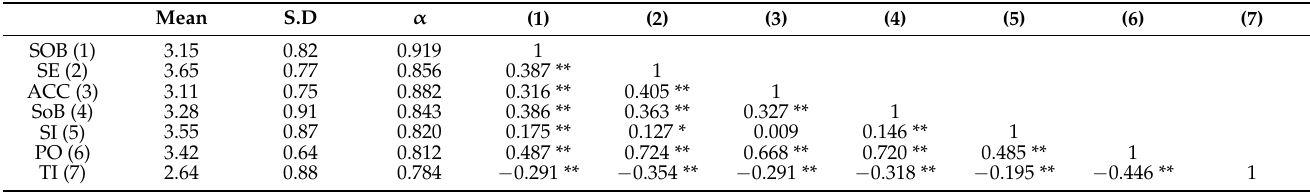
Table 3. Descriptive statistics, reliability, and correlation analysis.